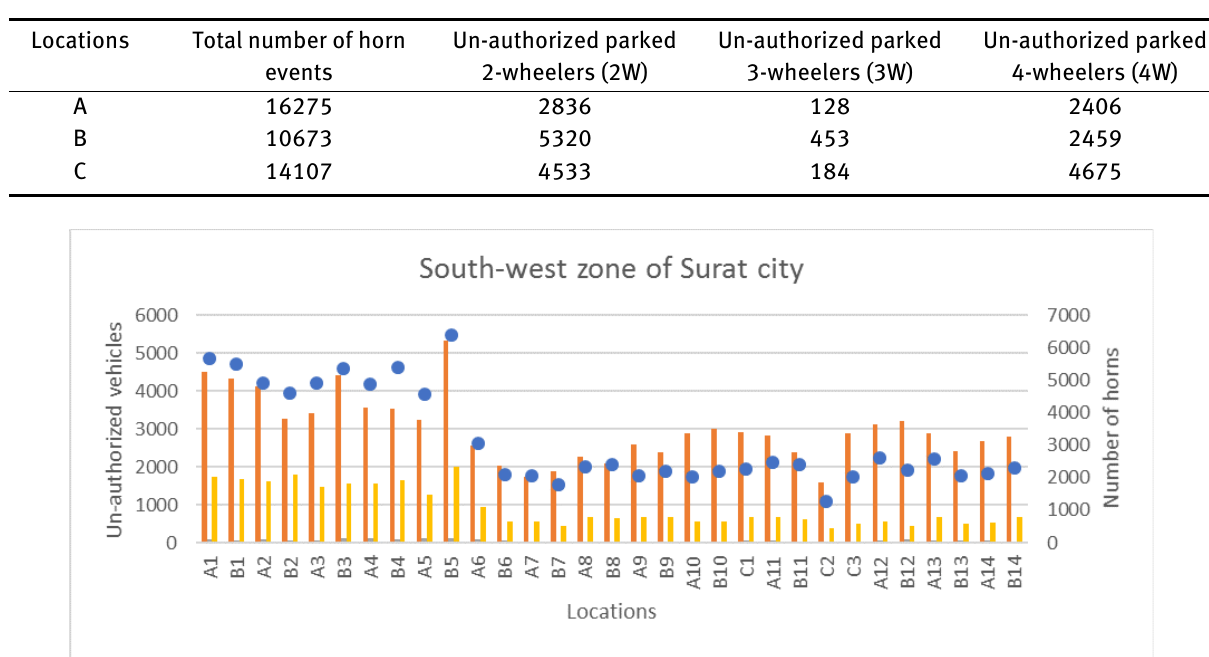
them. It can be concluded that noise as a dependent vari- able is having a linear relationship with un-authorized parked vehicles and a number of horn events. Therefore, multiple linear regression model is prepared which is an addendum/modification to RLS-90